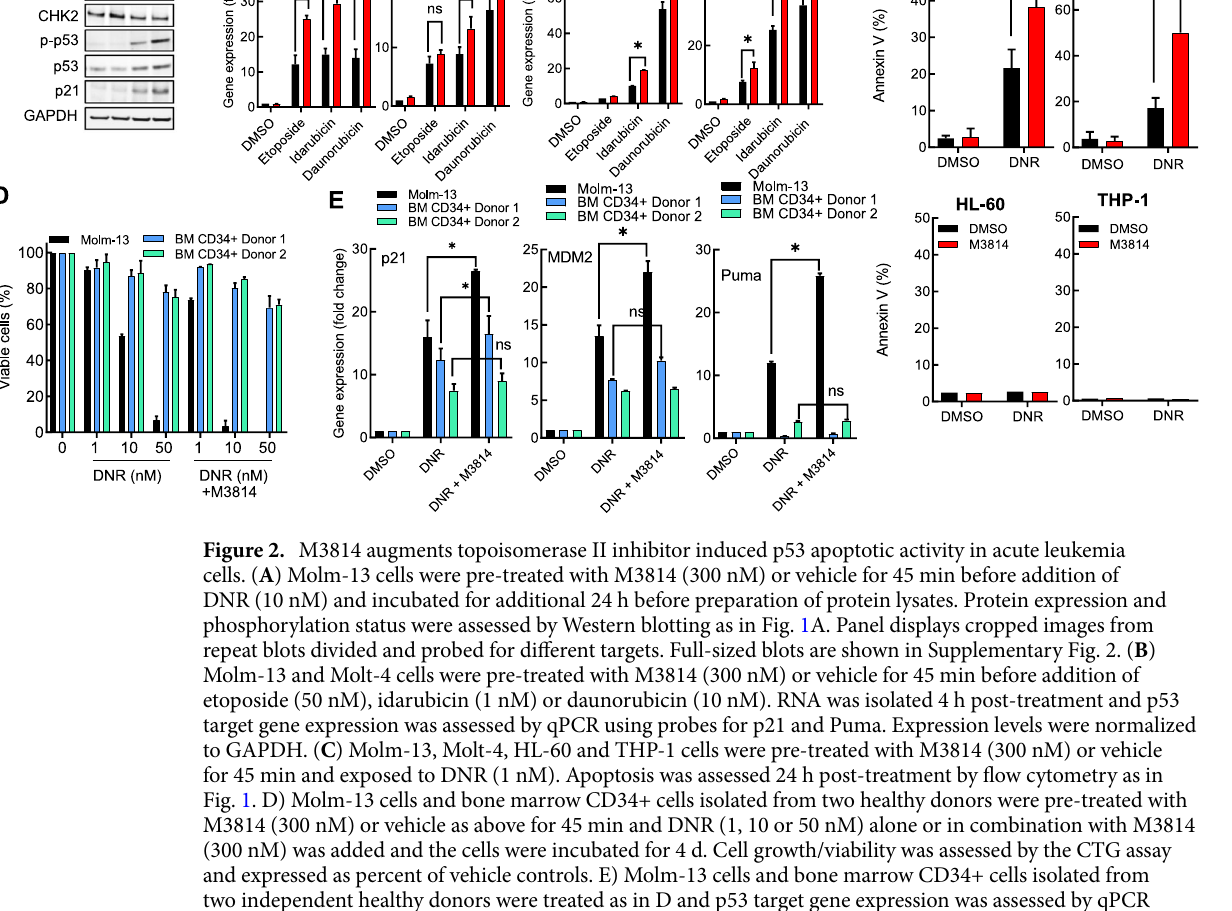
ML-2, M-07e (Fig. 3A). As expected, FLT3-ITD cell lines, Molm-13 and MV4-11, showed substantially lower